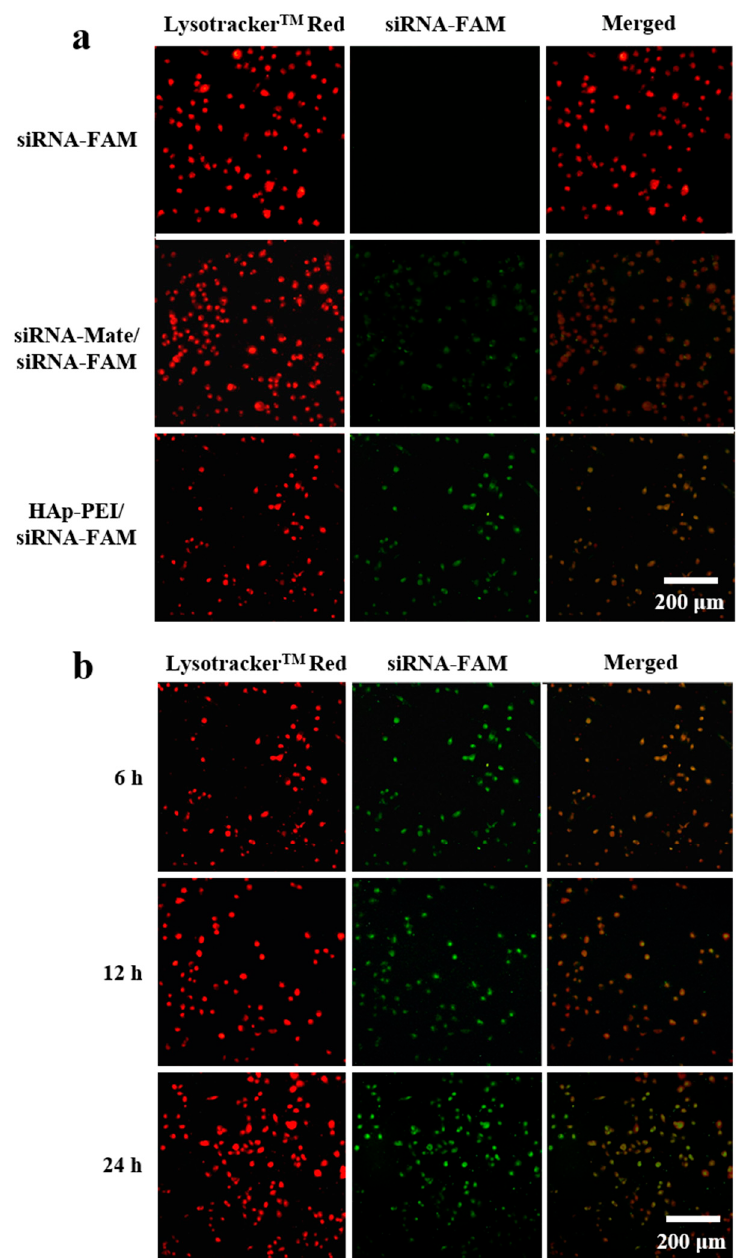
Figure 6. The pancreatic cancer cell PANC-1 transfected siRNA-FAM (green fluorescence) by ( a ) siRNA-Mate and HAp-PEI for 8 h and ( b ) HAp-PEI for 6, 12, and 24 h. Cell lysosome was stained with Lysotracker TM Red (red fluorescence).